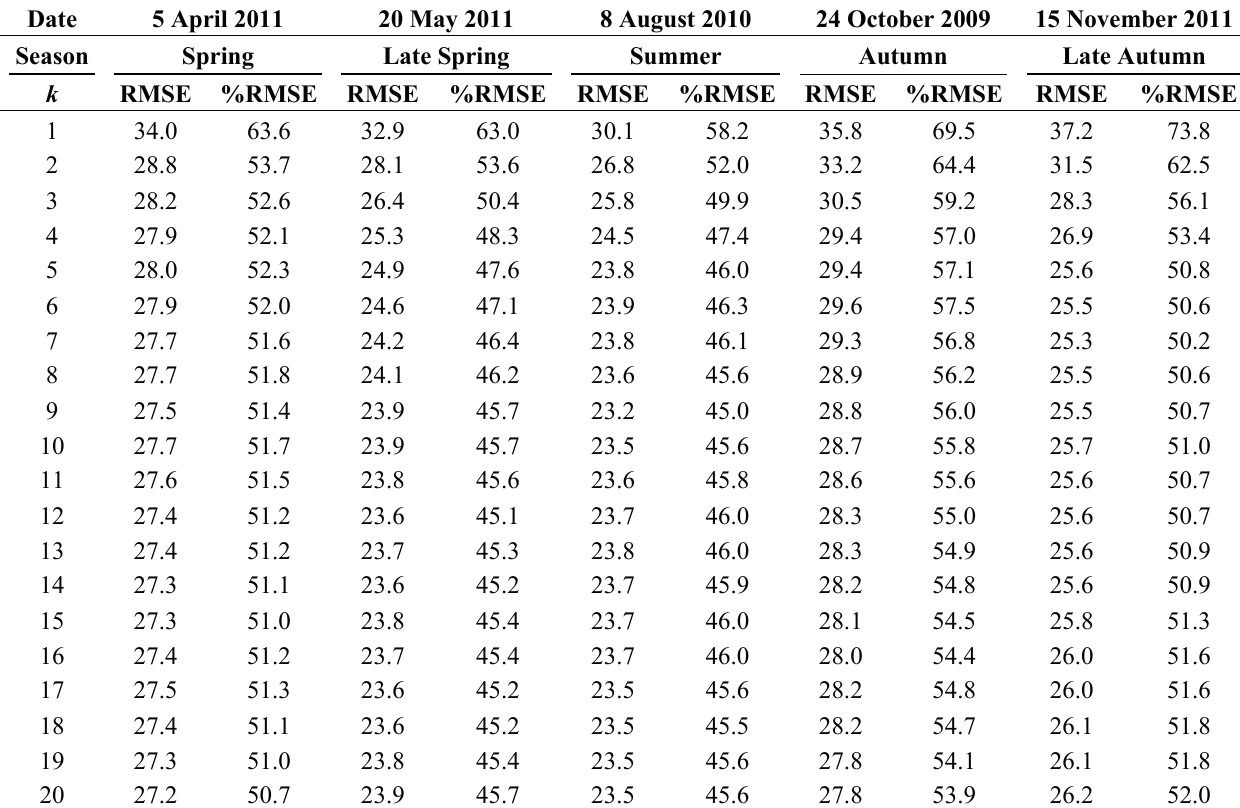
Table 3. Accuracy assessment results of AGB at Gongju and Sejongsites in different seasons: RMSE (unit: tonC/ha) and %RMSE (unit: %).